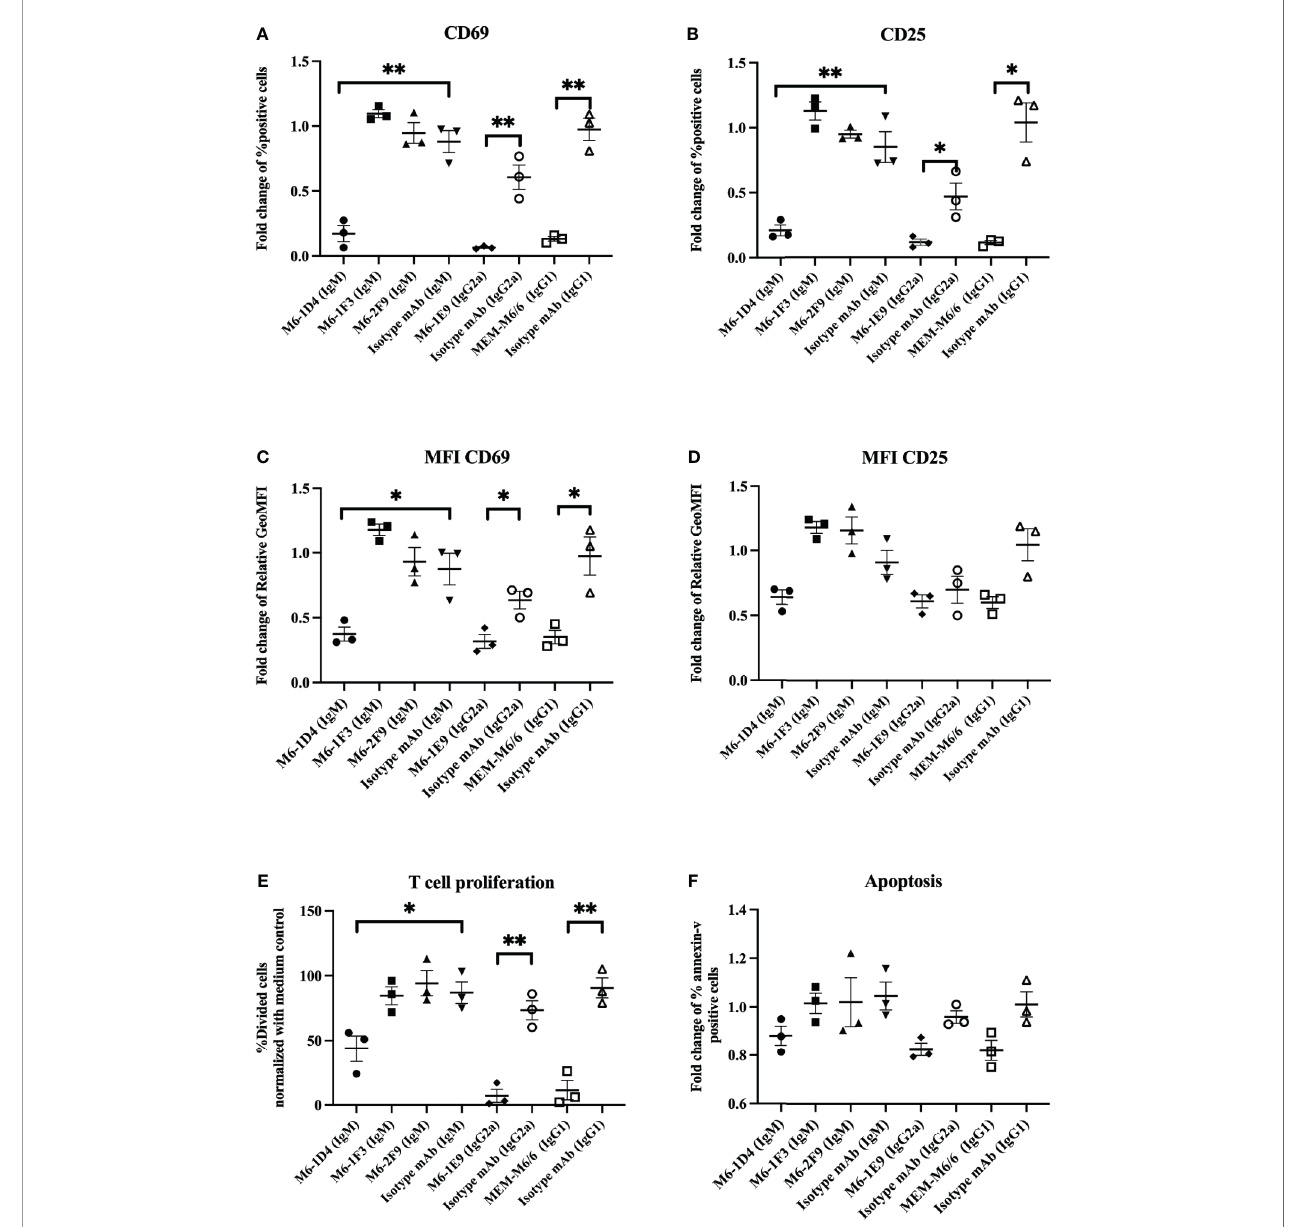
FIGURE 1 | Inhibitory effect of anti-CD147 mAbs on T cell activation. PBMCs ( n=3 ) were stimulated with a suboptimal dose of anti-CD3 mAb in the presence or absence of the indicated anti-CD147 mAbs. T cells were gated for the determination of CD69 and CD25 expression. The fold changes of % CD3 + CD69 + cells (A) and CD3 + CD25 + cells (B) are shown in the graph and indicate the mean ± SE. The fold change of geometric mean fl uorescence intensity (GeoMFI) of CD69 (C) and CD25 (D) are exhibited. The % divided cells (mean ± SE) at day 5 are shown in bar graphs (E) . The bar graphs show the fold change of annexin-V-positive cells (F) . Fold changes are relative to the medium control condition. Statistical analysis was performed using an unpaired t-test. * represents p ≤ 0.05 and **p ≤